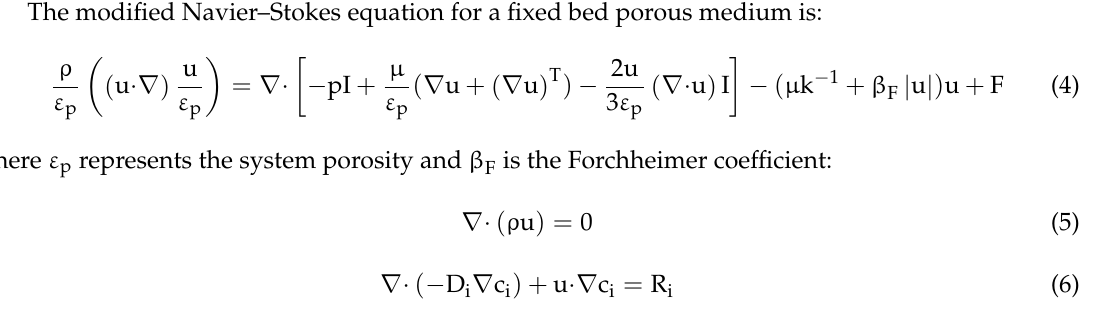
Figure 2. Configuration of the CMR simulation depicting the two catalyst sections, the location of the membrane and the size and geometry of the used mesh.